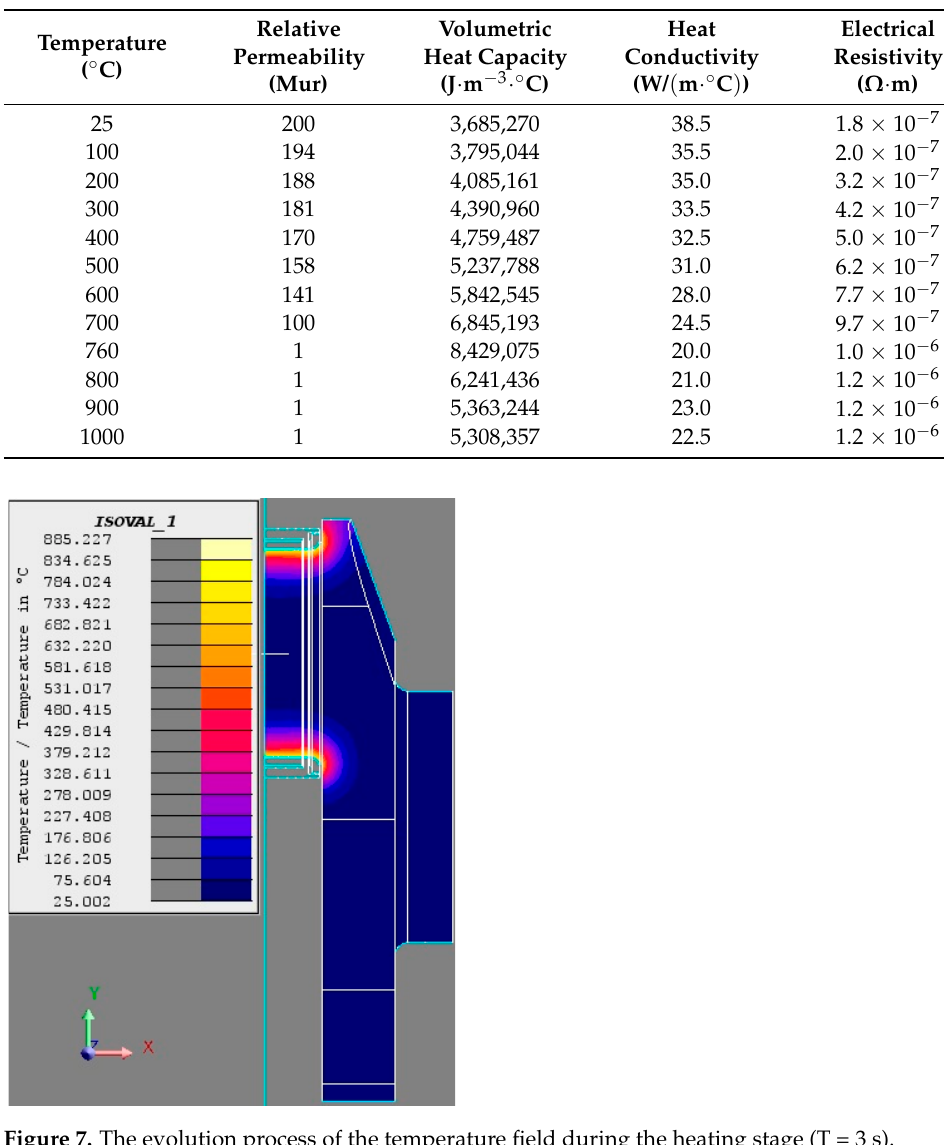
Table 2. Material properties of the crankshaft.